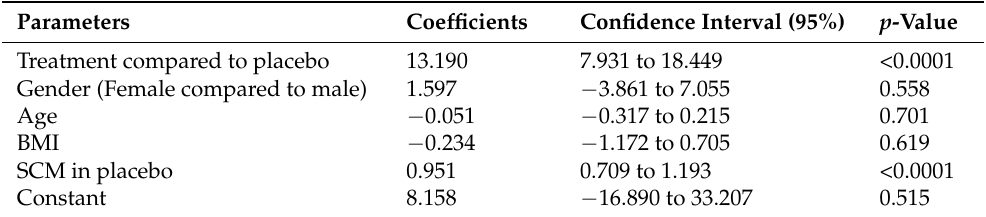
Table 5. Linear regression analysis of changes in the stratum corneum moisture (SCM) after 4 h of treatment.